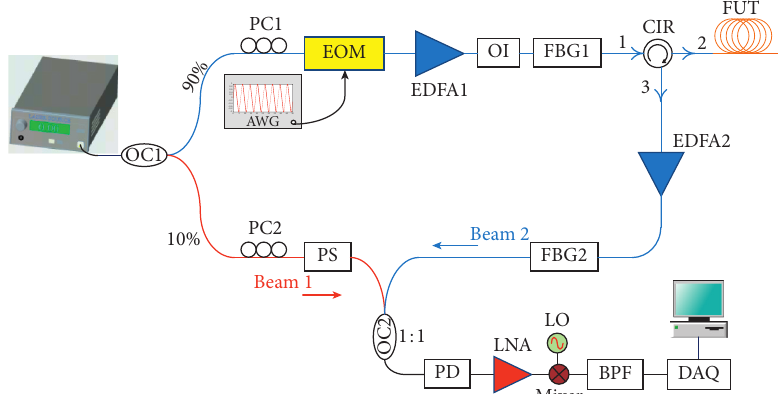
Figure 1: Schematic diagram of experimental apparatus. OI: optical isolator; OC: optical coupler; BPF: band-pass filter; PS: polarization scrambler; AWG: arbitrary waveform generator; PD: photodetector; DAQ: data acquisition card; EOM: electro-optic modulator; EDFA: erbium-doped fiber amplifier; FUT: fiber under test; FBG: fiber Bragg grating; CIR: circulator; LNA: low-noise amplifier; LO: local oscillator; PC, polarization